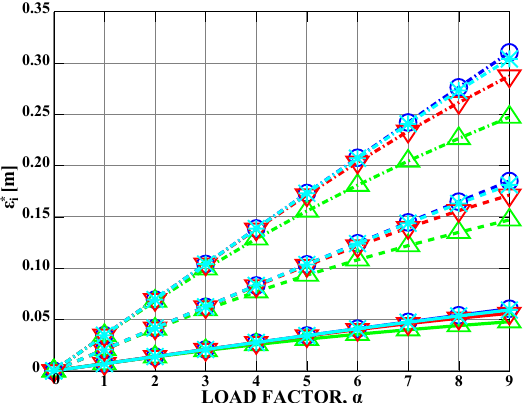
(solid line), ε ∗ 1 2